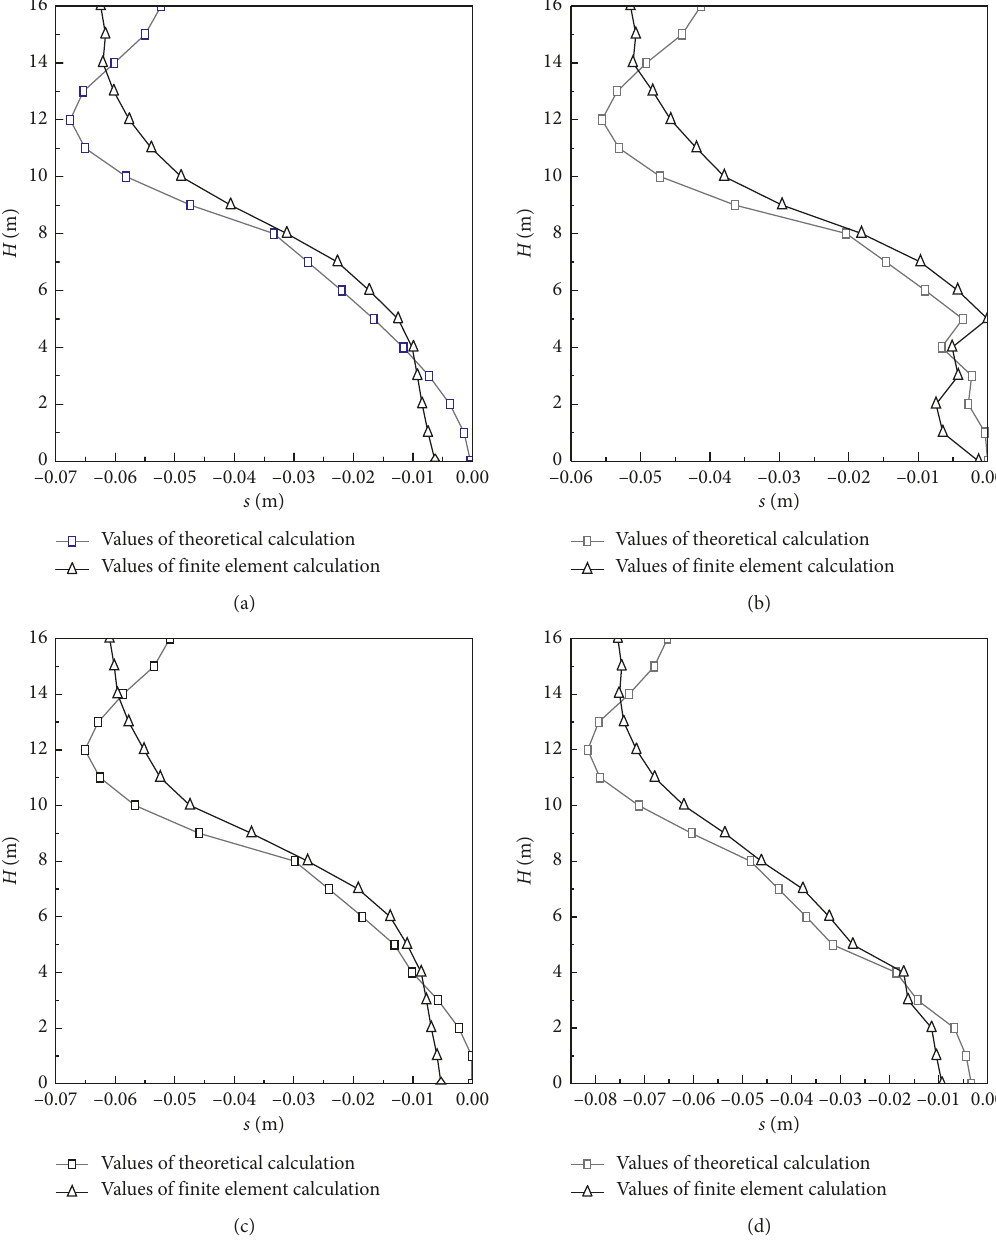
Figure 7: Comparison between calculation results of displacement for theoretical method and FE method. Working condition: (a) ① ; (b) ② ; (c) ③ ; (d) ④